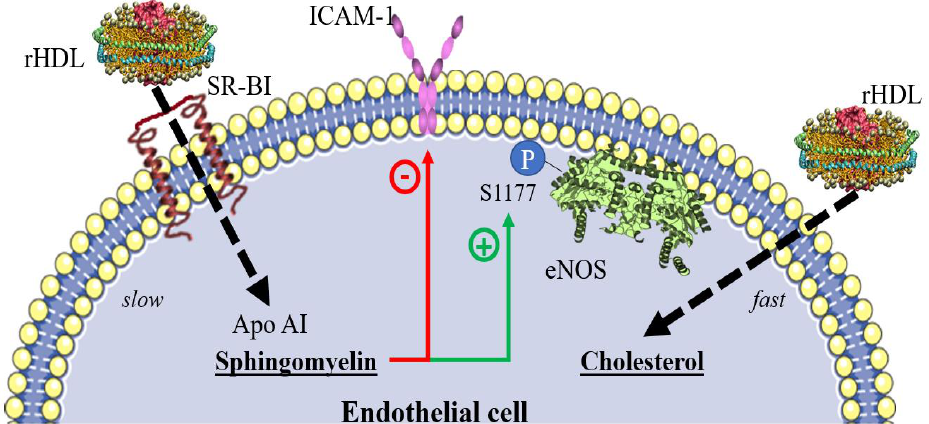
Figure 2. Lipids delivered to endothelial cells by HDL, according to Muñoz et al. [67]. Reconstituted HDL (rHDL) delivers cholesterol and sphingomyelin to HMEC-1 cells in culture. Cholesterol becomes integrated into the cells within the first 10 min in an SR-BI-independent manner. In contrast, SR-BI-dependent sphingomyelin and apo AI kinetics are slower, reaching the maximal delivery in about 30 min. The content of sphingomyelin in rHDL, but not of cholesterol, determines the TNF-induced expression of ICAM-1 and eNOS phosphorylation in the Ser 1177. VCAM-1 expression was not affected by any component of rHDL.